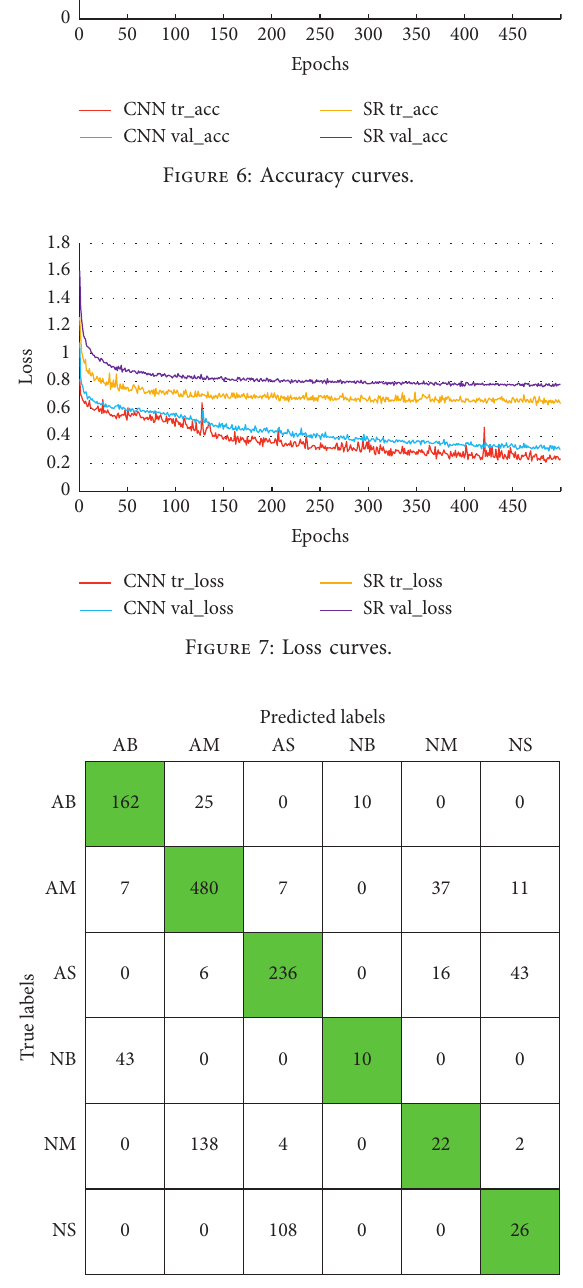
Figure 8: Confusion matrix of the SR model.